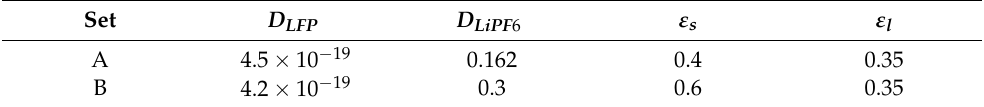
Figure 19. Validation of the lamellar structure on the basis of the cellular parameter set. Table 4. Set of parameters for sets A and B in Figure